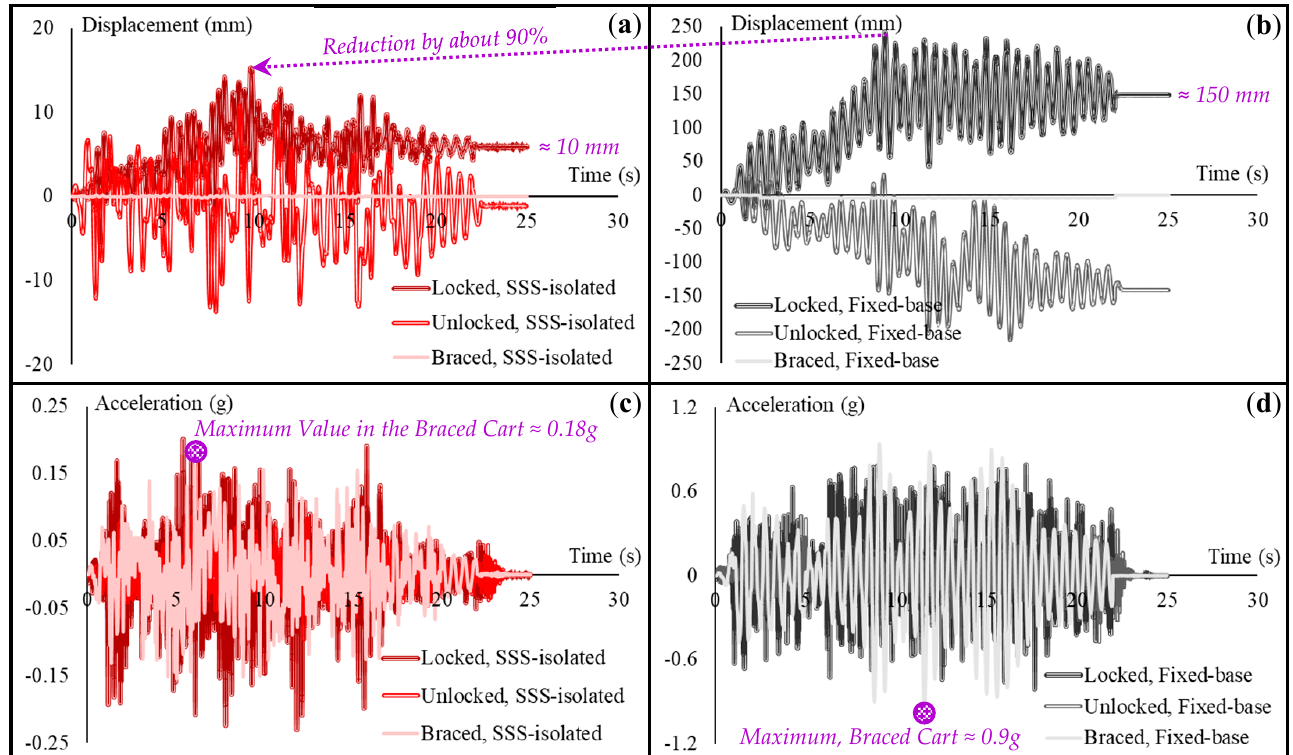
Figure 11. Comparative diagrams of the seismic responses of the cart in the locked, unlocked, and braced conditions: ( a ) displacement responses in the SSS-isolated case; ( b ) displacement responses in the fixed-base case; ( c ) acceleration responses in the SSS-isolated case; ( d ) acceleration responses in the SSS-isolated case.